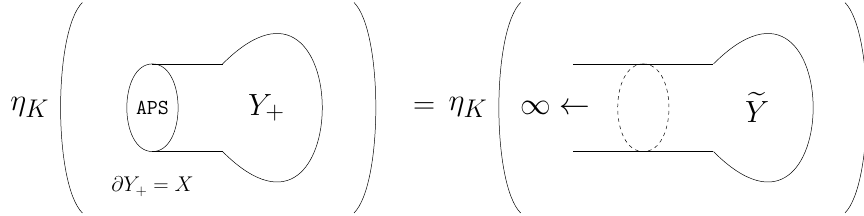
Figure 2 . The APS boundary condition can be replaced by an infinite half cylinder. All the mass parameters and the background gauge fields are independent of the longitudinal direction along the half